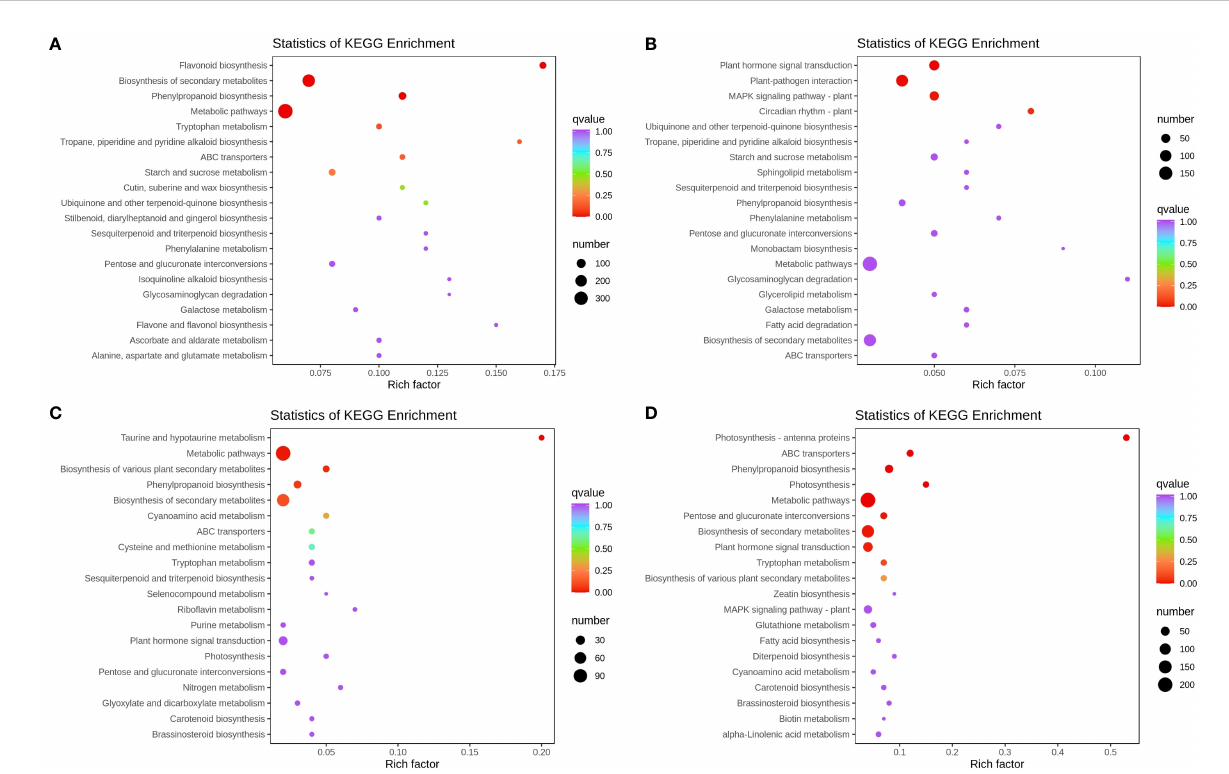
FIGURE 2 Statistics of KEGG enrichment under different K conditions in apple leaves and roots. (A) Statistics of KEGG enrichment under low-K conditions in apple leaves. (B) Statistics of KEGG enrichment under high K conditions in apple leaves. (C) Statistics of KEGG enrichment under low-K conditions in apple roots. (D) Statistics of KEGG enrichment under high K conditions in apple roots.